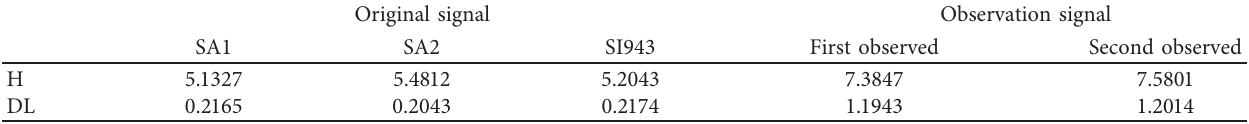
Table 2: Entropy (H) and disorder levels (DLs) between source speech signal and observed signal.